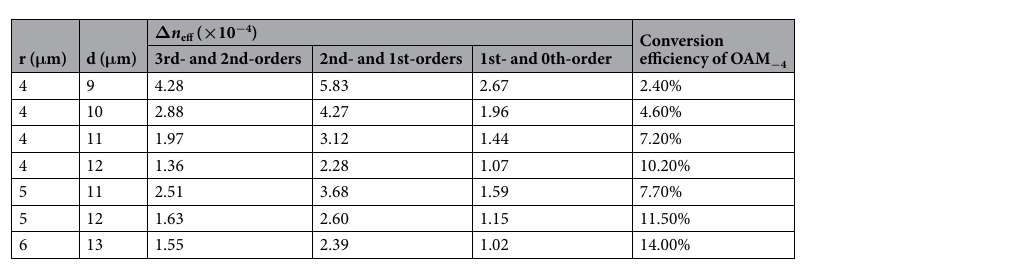
Table 1. Normalized power of different OAM channels.